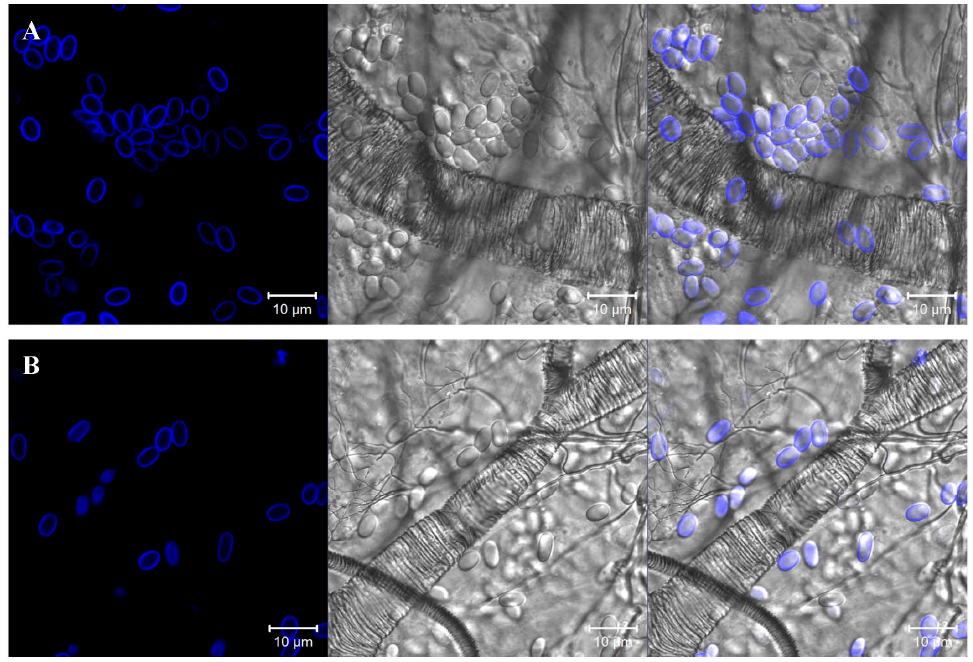
Figure 5. Confocal microscopic images of the midguts of honeybees infected with untreated ( A ) and porphyrin-treated ( B ) Nosema spores. λ exc = 405 nm.